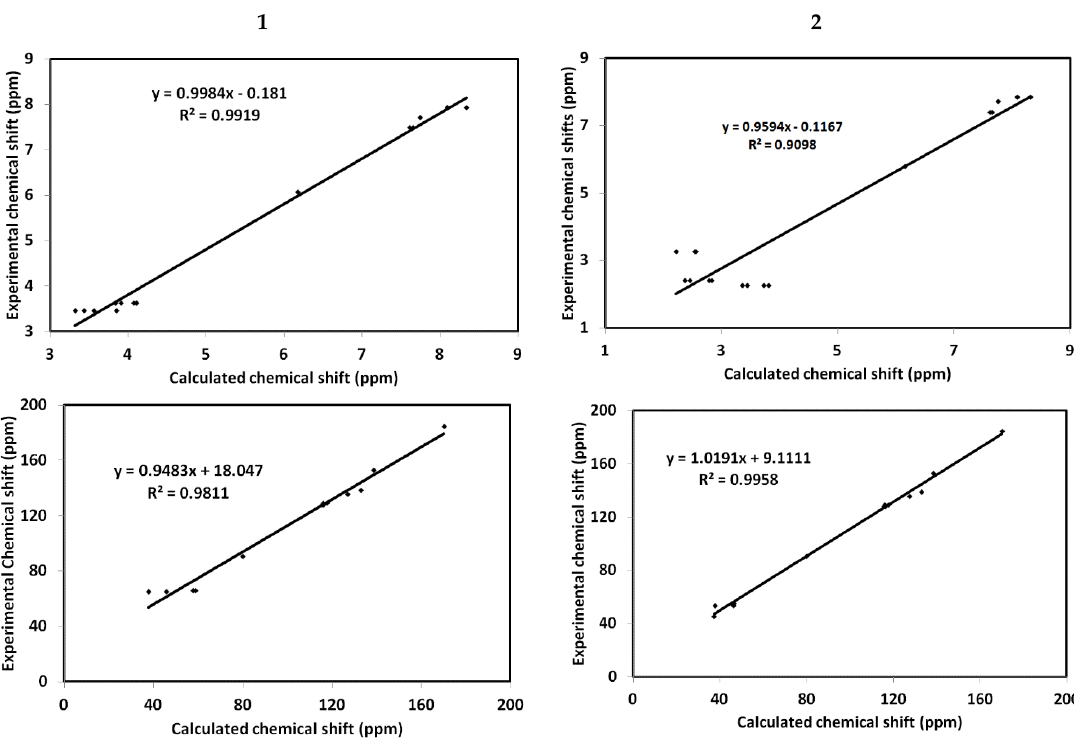
Figure 11. Correlation between calculated and experimental 1 H (upper) and 13 C (lower) NMR chemical shifts for compounds 1 (left), and 2 (right).